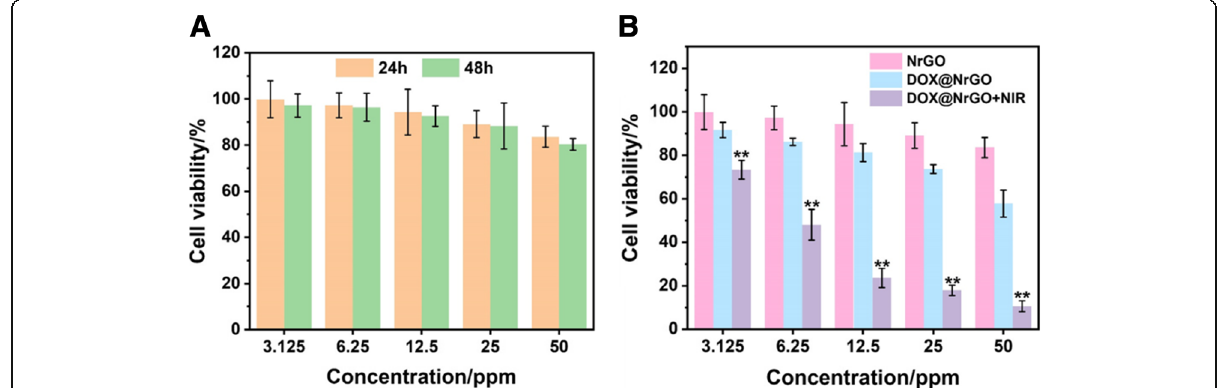
Fig. 10 a Cytotoxicity test of NrGO at different concentration for 24 h and 48 h. b Tumor cell inhibition investigation of DOX@NrGO with different treatment